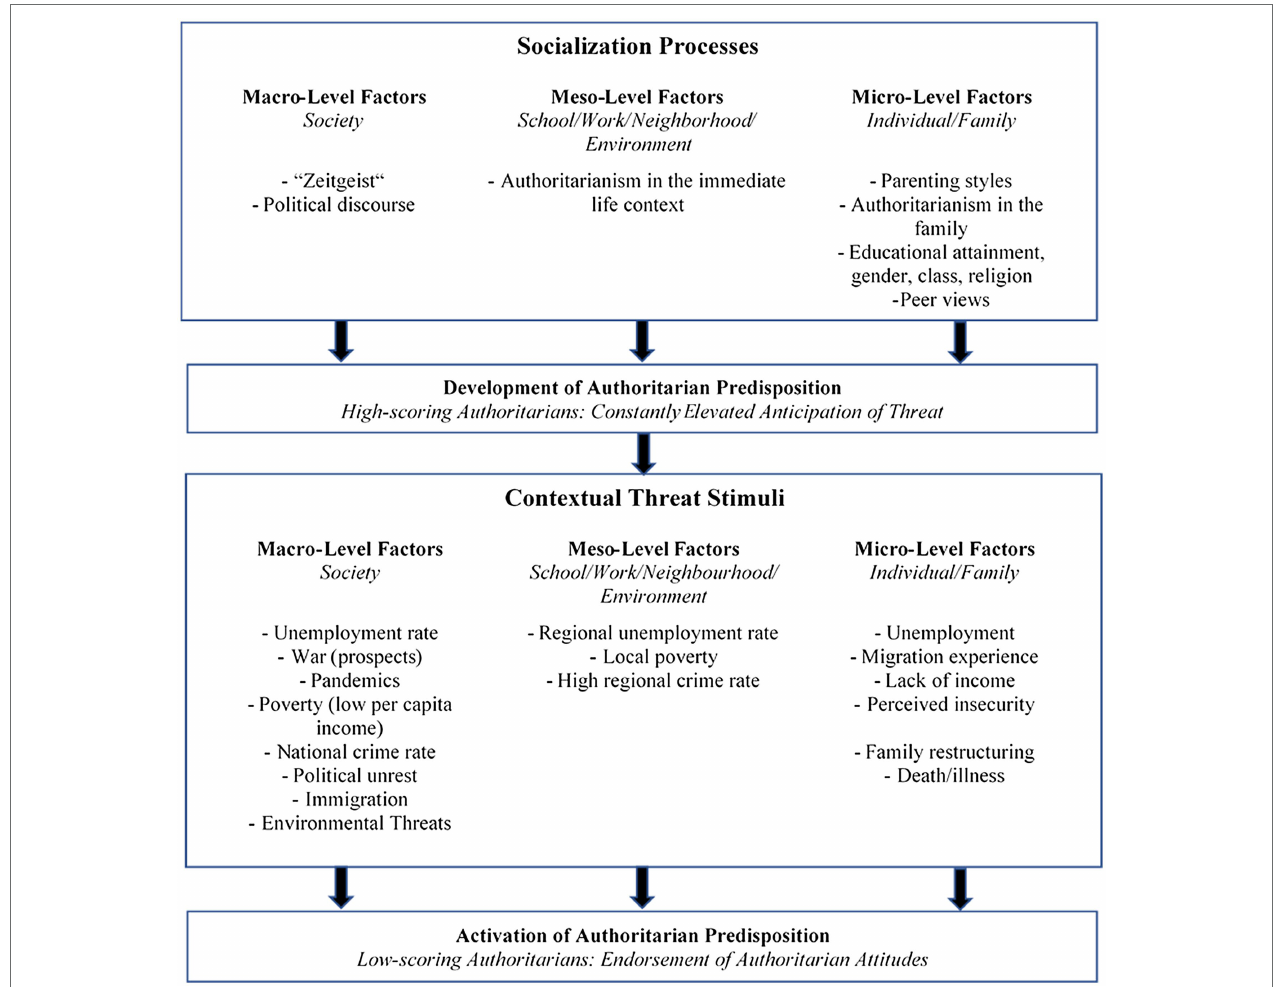
FIGURE 1 | Multilevel model of the “Authoritarian Reaction” in high-scoring and low-scoring